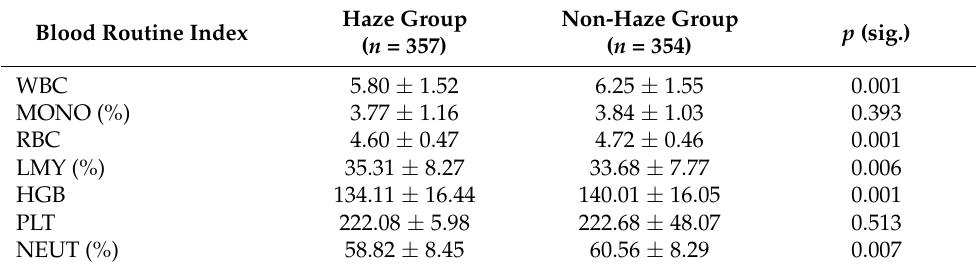
Haze Group Non-Haze Group ( n = 357) ( n = 354)